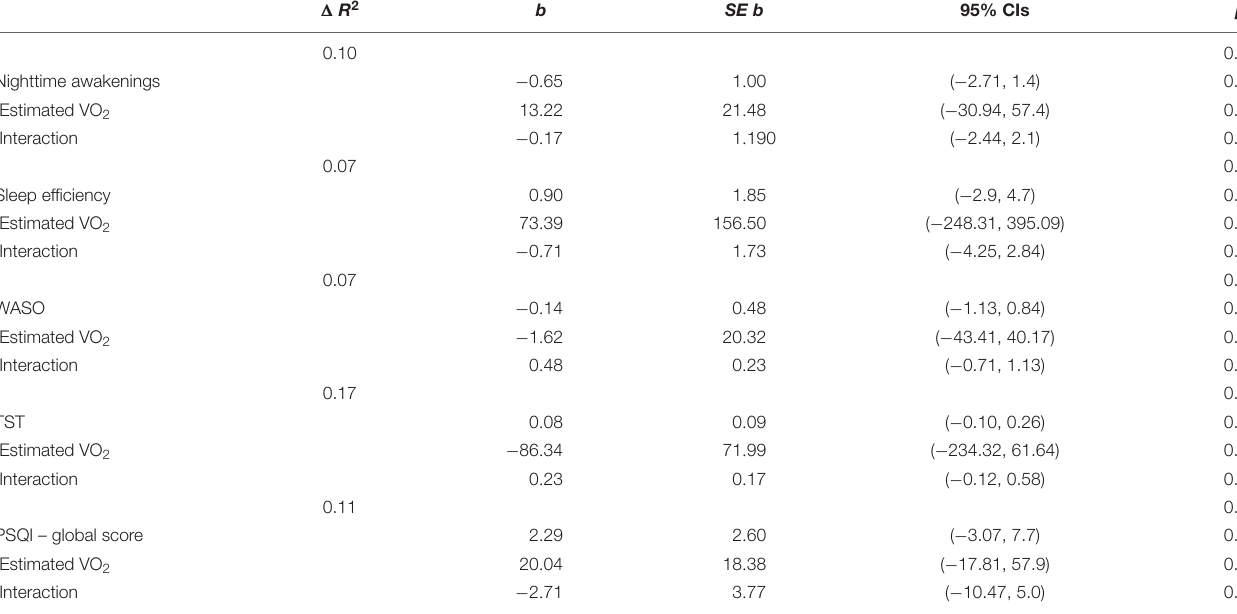
TABLE 3 | Regression coefficients of the moderating effect of cardiorespiratory fitness and sleep on high-interference memory, in young adults. (cid:49) R